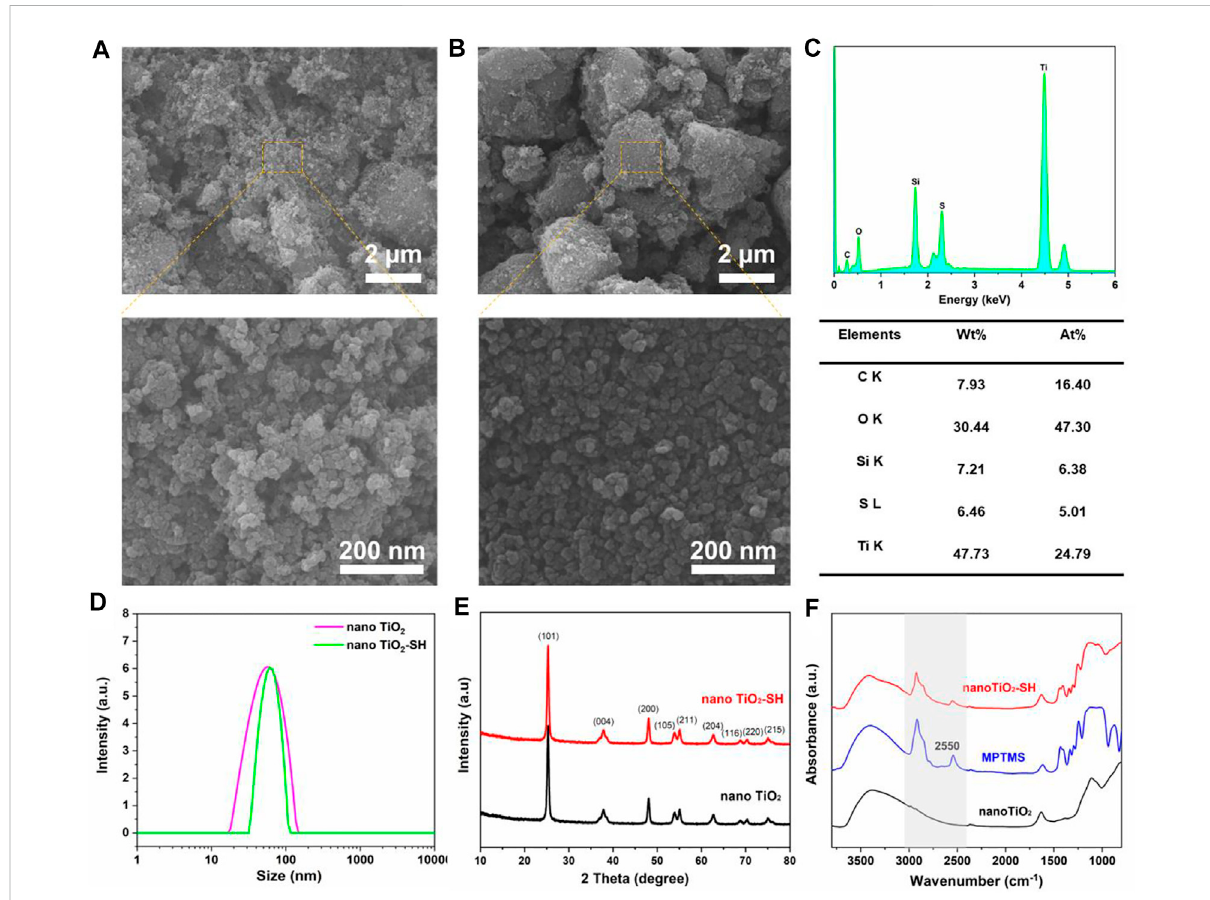
FIGURE 2 (A) SEMimageofnanoTiO 2 . (B) SEMimageofnanoTiO 2 -SH. (C) ContentofvariouselementsinnanoTiO 2 -SH. (D) Theparticlesizedistribution of nano